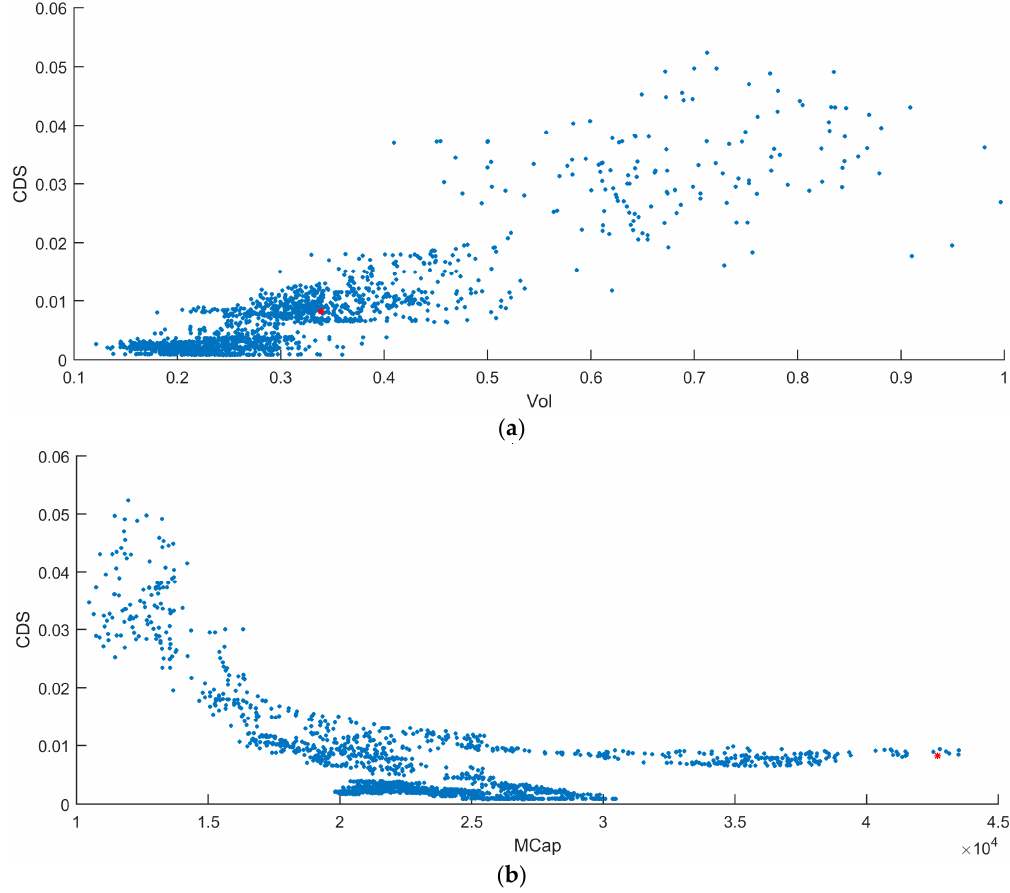
Figure 7. Scatter plot for BMW: ( a ) five-year CDS versus 10-delta implied volatility; ( b ) five-year CDS versus market capitalization. The red point indicates the company’s position as of the last data point.